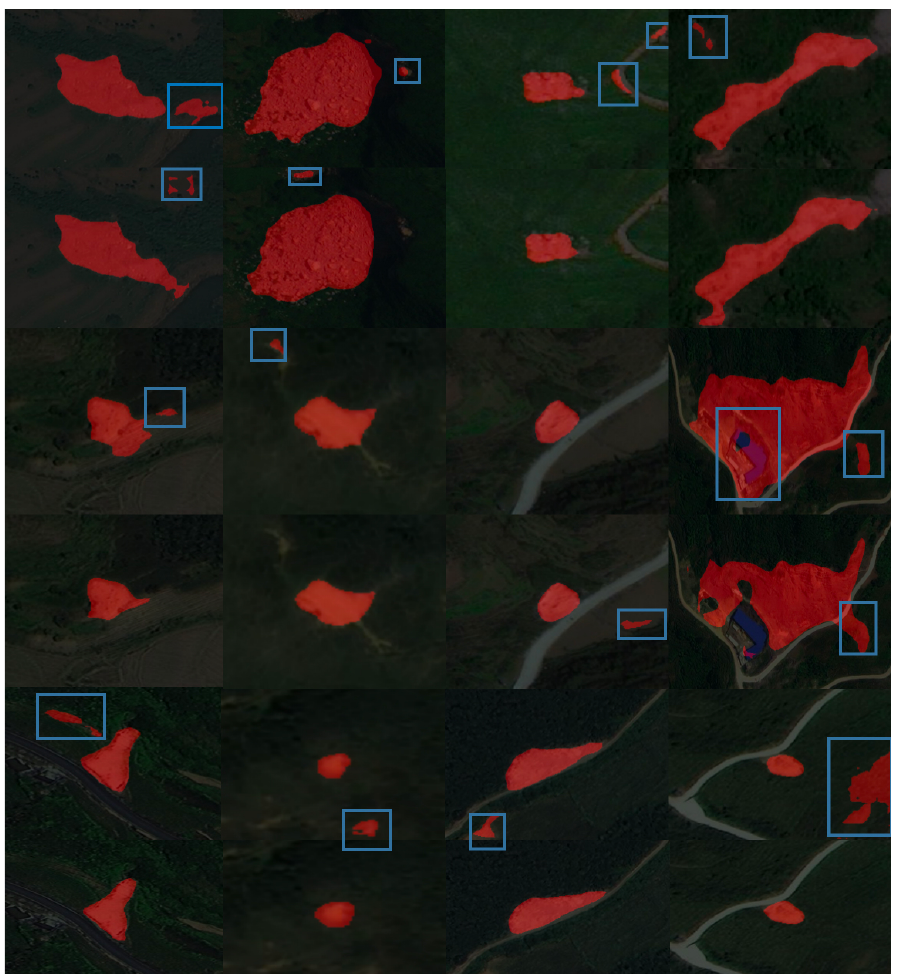
Figure 6. The comparison results of landslide identification of PSPNet using MobileNet and ResNet50 as the backbone network, respectively. Behaviors 1, 3 and 5 use MobileNet as the identification result of the backbone network, and behaviors 2, 4 and 6 use ResNet50 as the identification result of the backbone network. The blue box marks the background pixels that the model misidentified as part of the